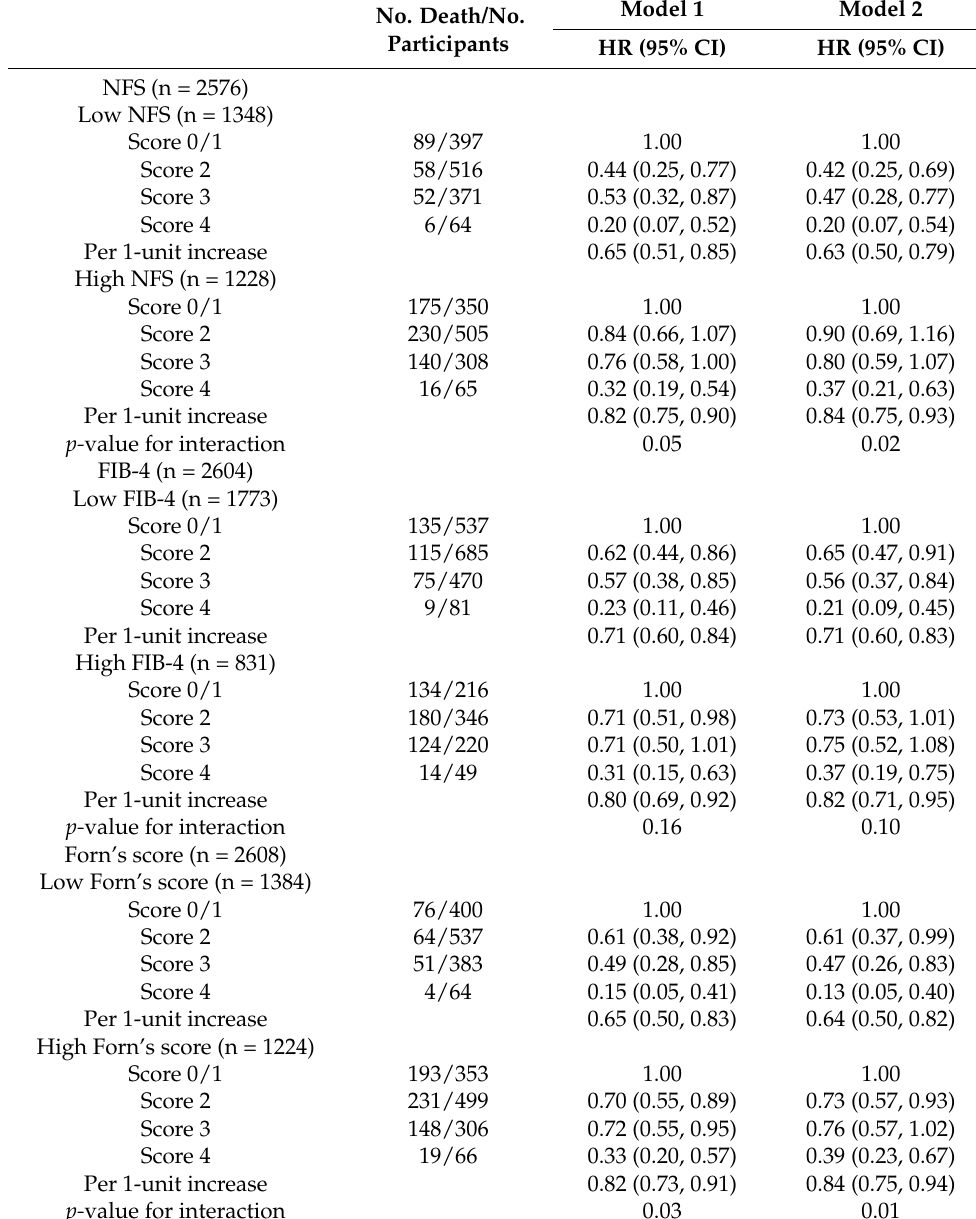
Table 3. Associations between healthy lifestyle and all-cause mortality in MAFLD participants with and without advanced